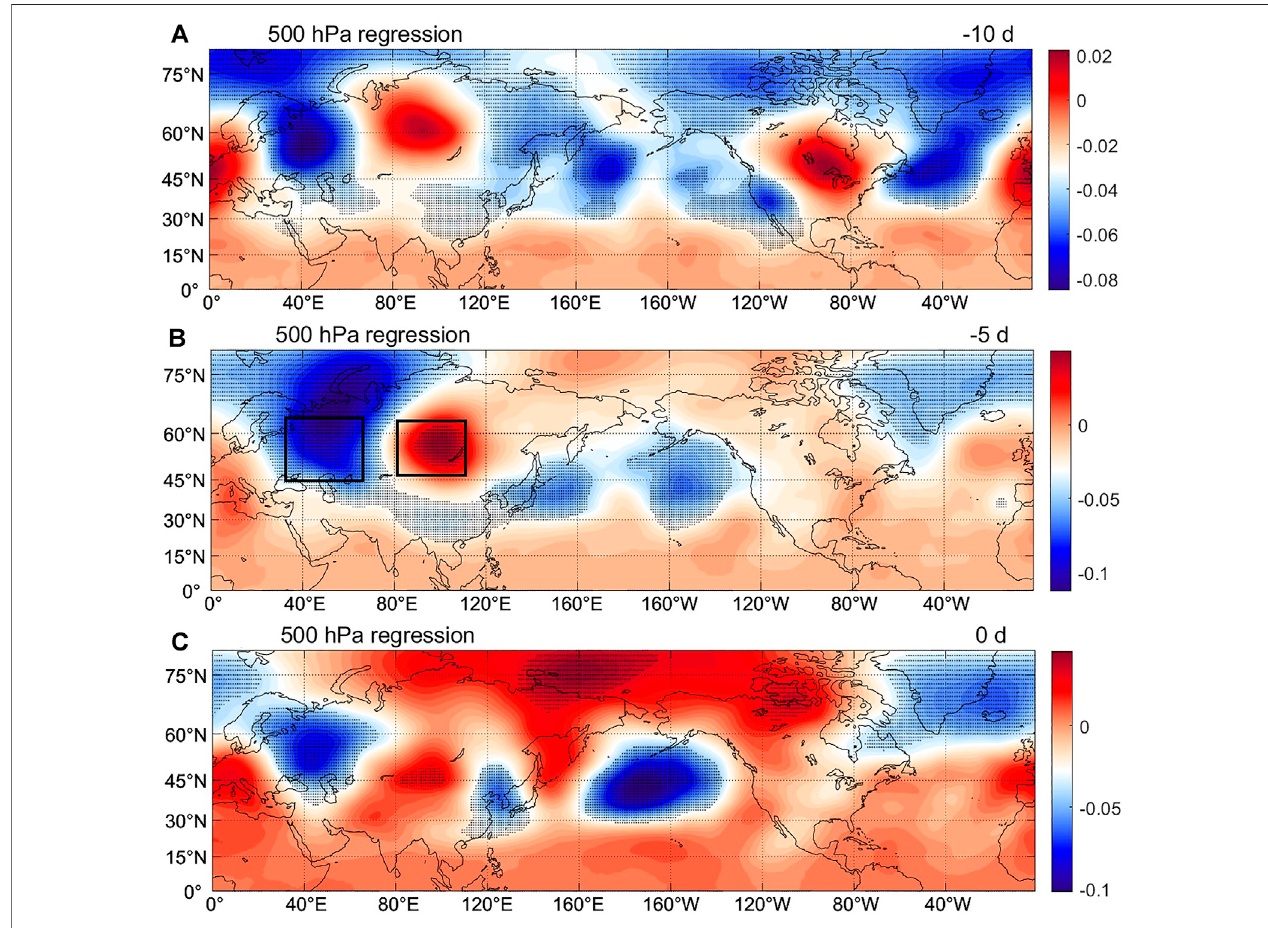
FIGURE 3 | Lead regression analysis of PM 2.5 concentration on the 500 hPa geopotential height fi eld (A) ten days before, (B) fi ve days before, and (C) day of.